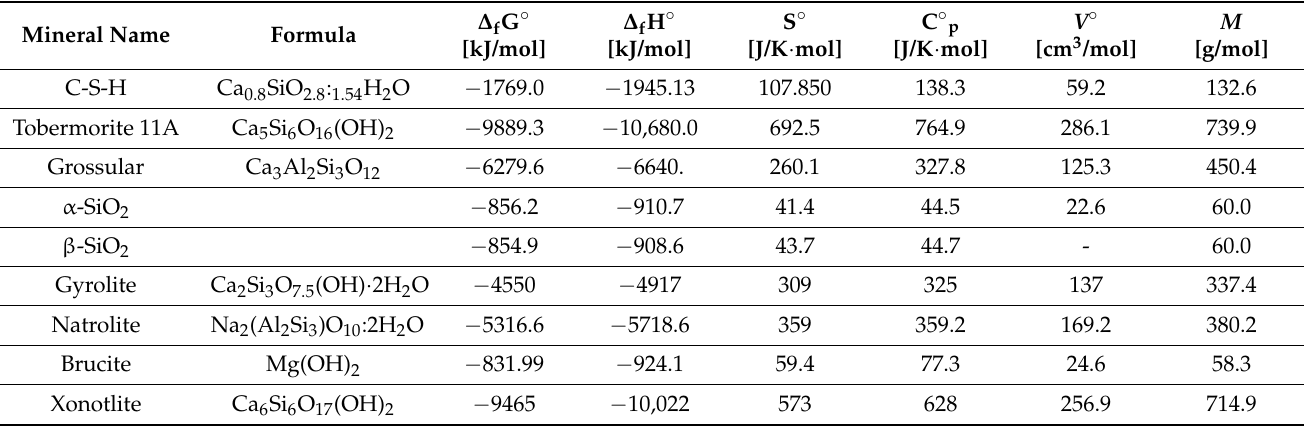
Table 4. Standard molar thermodynamic properties of minerals found in tested bricks